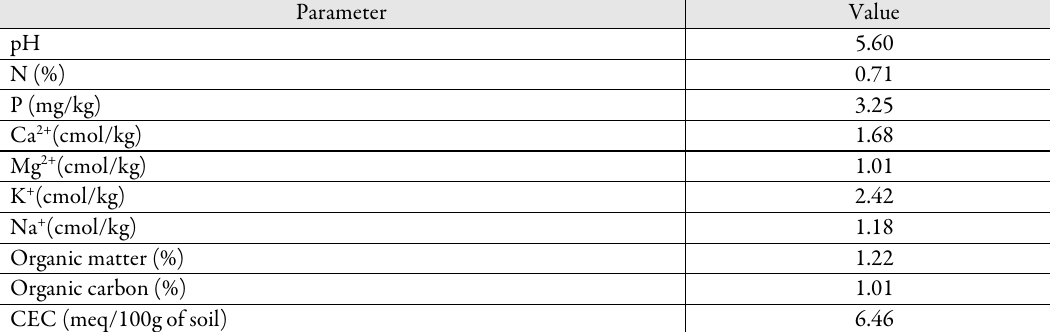
Table 1. Chemical properties of the